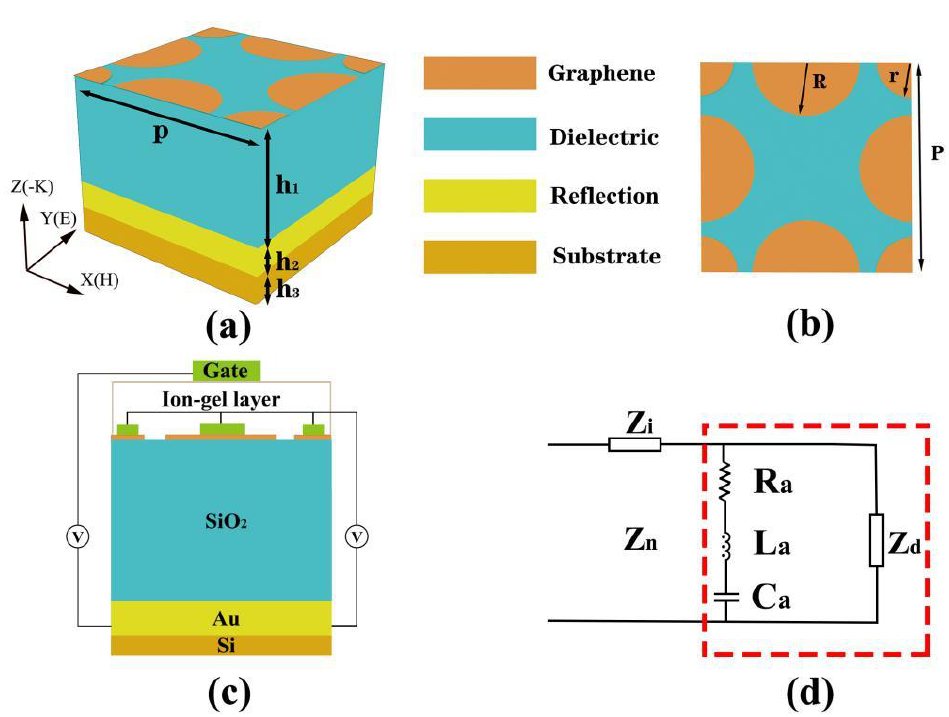
Figure 1. ( a ) Diagram of the graphene plasma absorber structure unit. The structural units are, from top to bottom, the reactive layer graphene, the dielectric layer silica (h 1 = 1 µ m), the reflective layer gold plane (h 2 = 0.25 µ m), and the silicon substrate as physical support (h 3 = 0.1 µ m). ( b ) Schematic diagram of the graphene-patterned layer structure, where the structural unit period P = 0.4 µ m, the large sector radius R = 0.11 µ m, and the small sector radius r = 0.08 µ m. ( c ) Diagram of the shared model for building the equivalent circuit and tuning the Fermi energy level. ( d ) Diagram of the RLC equivalent circuit of our model. The impedance of the dielectric layer (silica) and the space-free impedance can be expressed by Z d and Z i , respectively. Z n is the equivalent impedance. The metal layer Au acts as a zero potential point and as a potential reference. R a , L a , and C a are the resistances, capacitances, and inductances of the sector graphene layer, respectively.